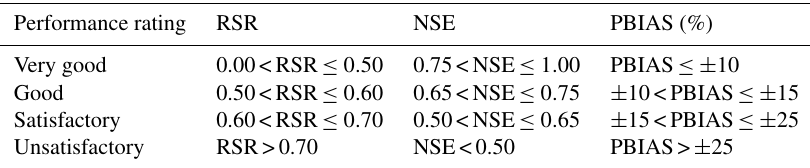
Table 2. General performance ratings statistics recommended by Moriasi et al.